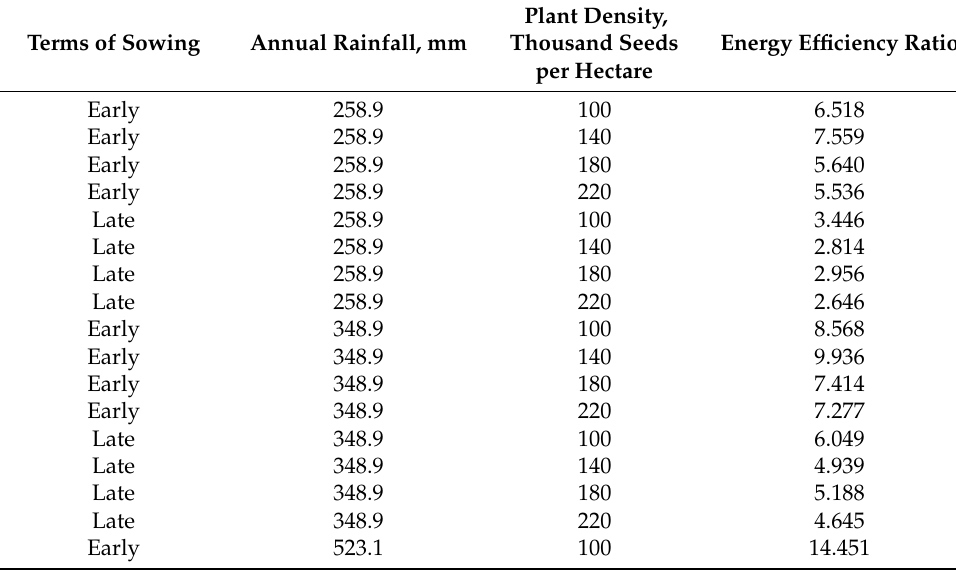
Table 12. Energy efficiency